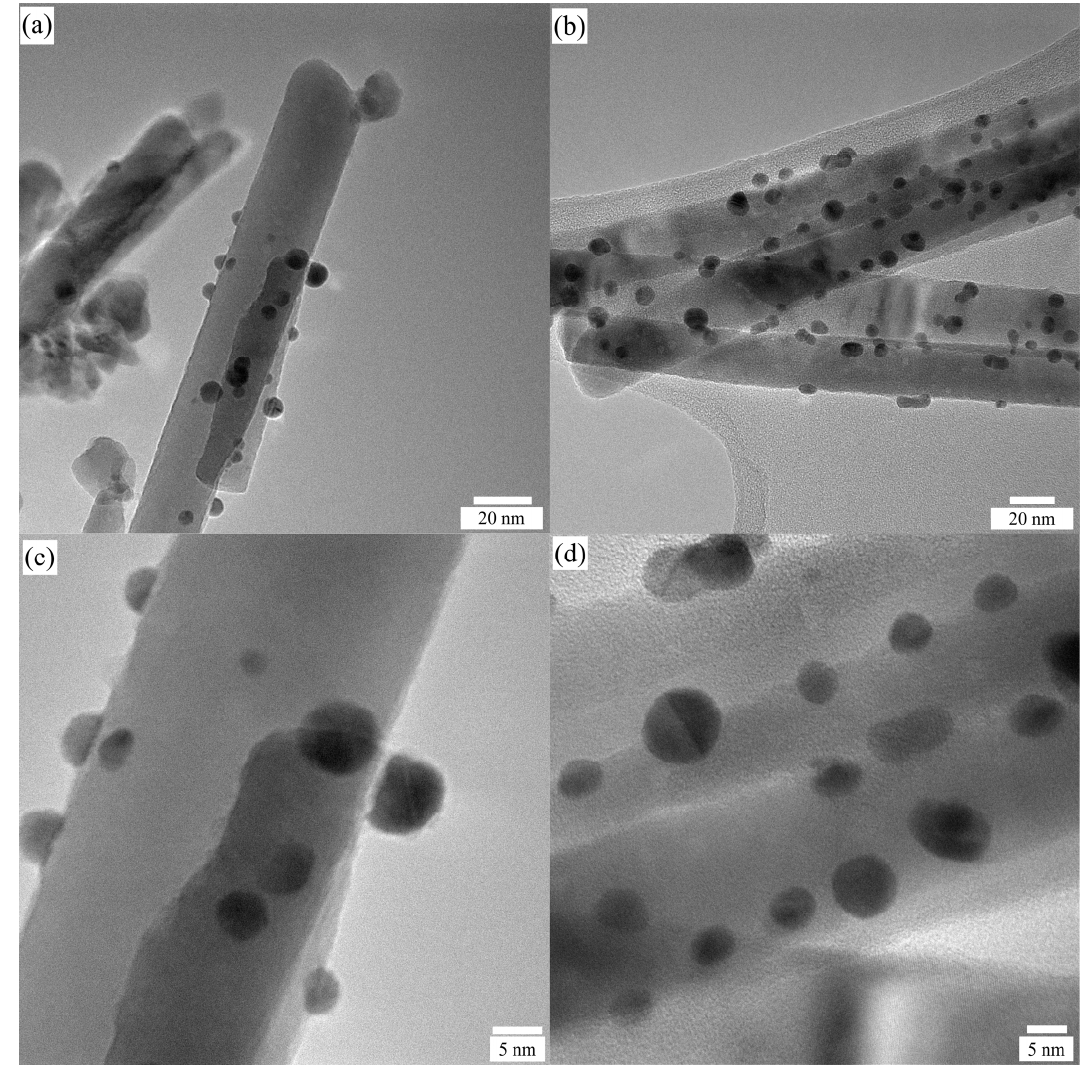
Figure 3. TEM images of ( a ) Au/ZnO and ( b ) grad-Au/ZnO, and HRTEM images of ( c ) Au/ZnO and ( d ) grad-Au/ZnO.